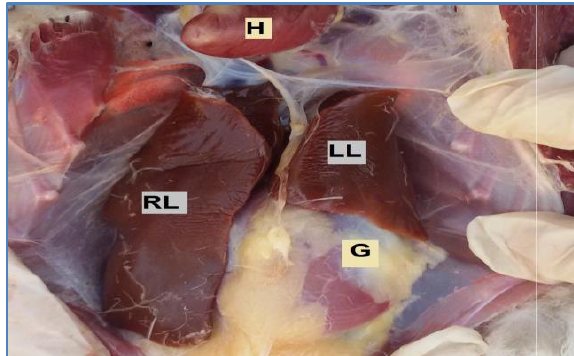
Figure, 2: Shows the location and shape of the liver in mallard duck. Left lobe (LL), Right lobe (RL), Heart (H), and gizzard (G).